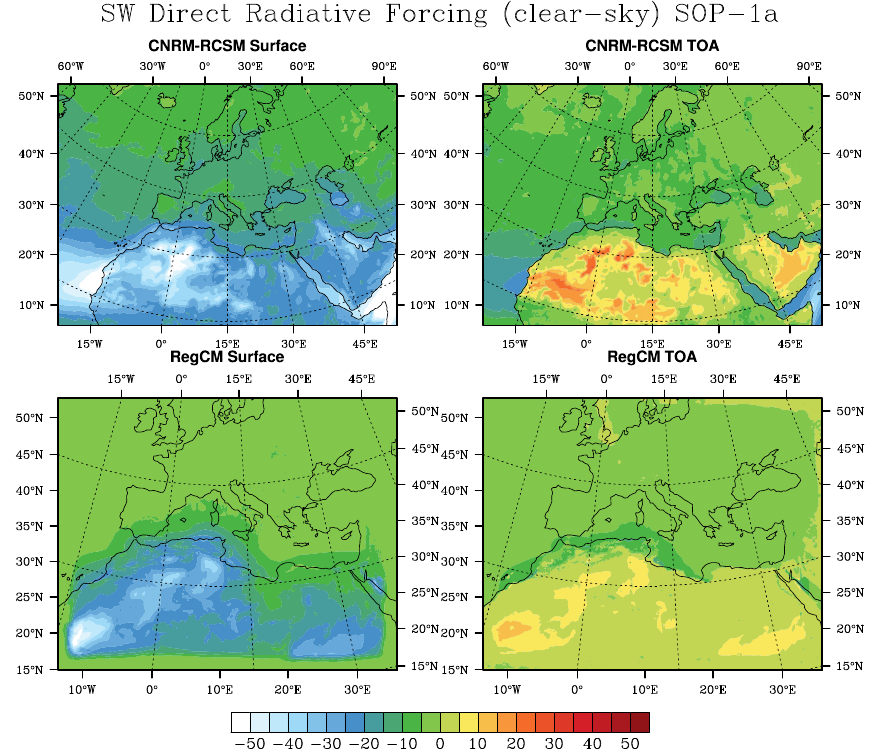
Figure 32. Averaged surface and TOA SW DRF simulated in clear-sky conditions and over the SOP-1a period by the CNRM-RCSM and RegCM